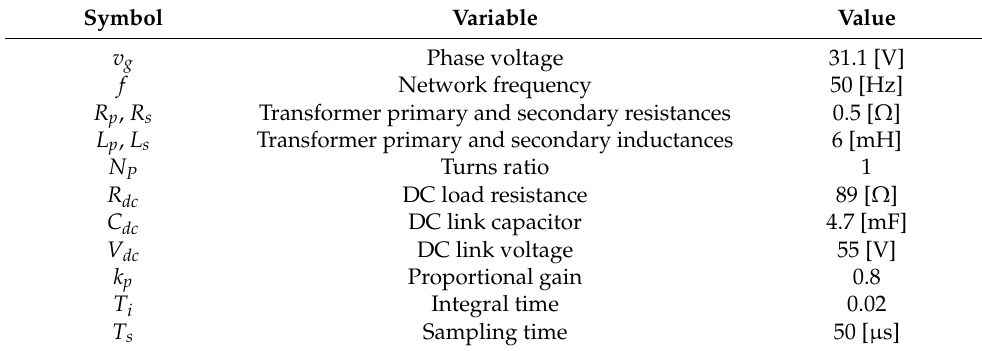
Table 3. Experimental Results.